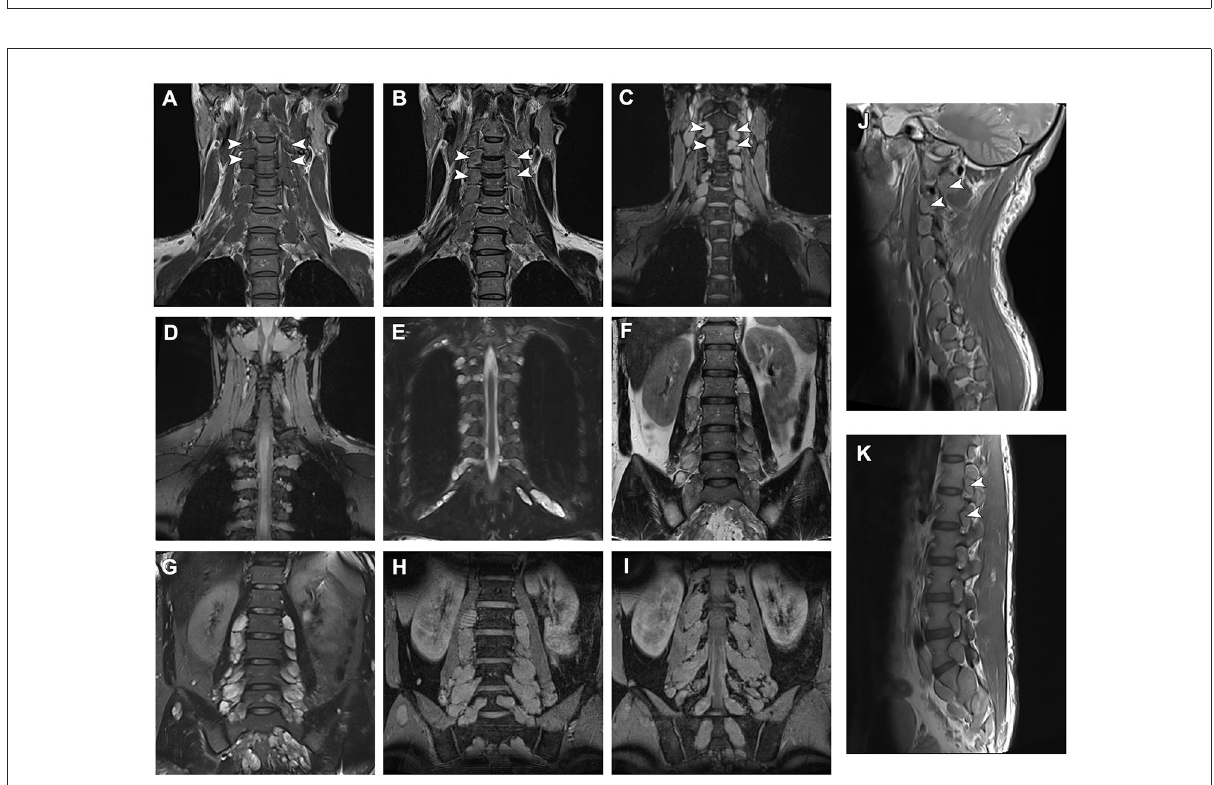
FIGURE2 Magnetic resonance imaging data of the patient and neurofibromas across all spinal roots. (A,B) T1- and T2-weighted and (C) Multiple Echo Data Image Combination (MEDIC) coronal sections of the cervical spine MRI demonstrating presumed neurofibromas affecting all nerve roots. (D,E) MEDIC and T2 sequence images of thoracic neurofibromas. (F) Fast spin echo and (G) turbo inversion recovery magnitude T2-weighted and (H,I) MEDIC coronal sections of the lumbar vertebrae demonstrating lumbar and sacral neurofibromas. (J,K) Sagittal T1 sequences of the spine demonstrating the proximal extension of the